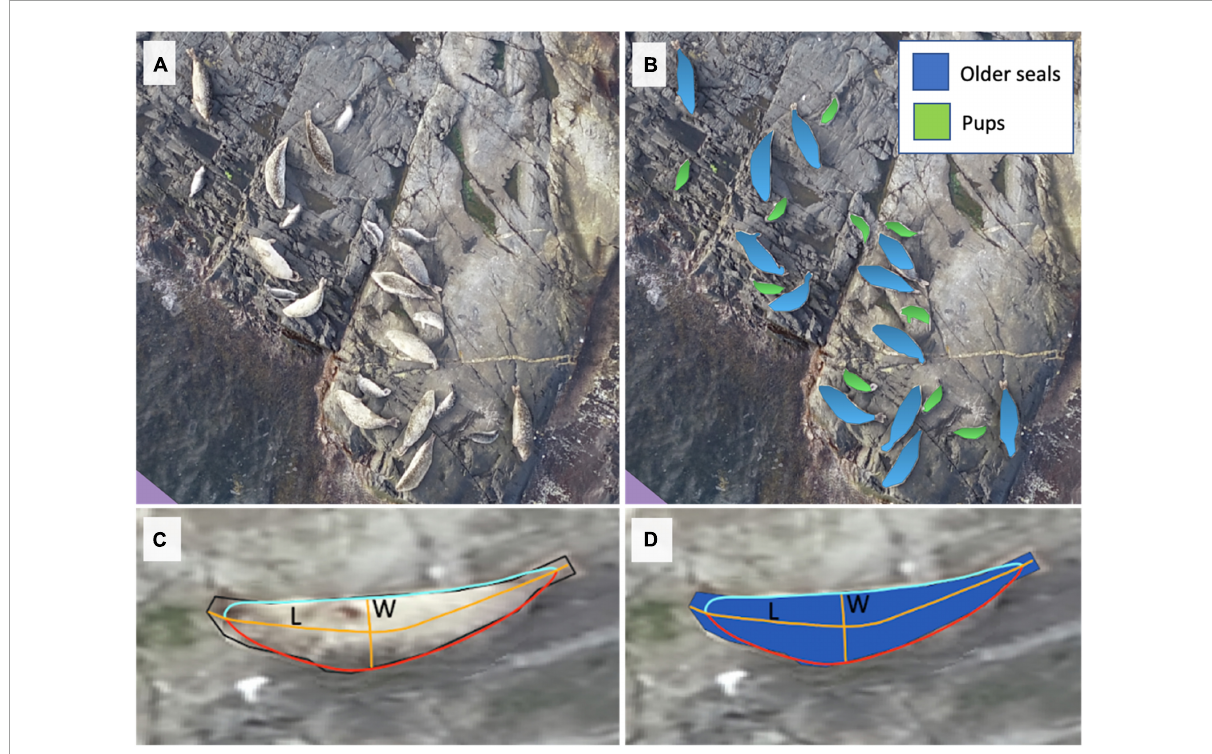
FIGURE3 Harbour seal identification using machine learning detectors at the locality “Svarta Kalvhättan,” Sweden, on the 18th of June 2021. (A) A drone orthomosaic map is composed of many overlapping photos. (B) Blue and green polygons indicate pups and older seals identified by machine learning, (C,D) automatic measurement of body lengths (L) and widths (W) describe seal shape. Polygons were smoothed and split into two line segments (red and light blue lines). Coordinate points midway between these segments were used to construct a line representing the position of the spine. To account for the effect of smoothing, the distance between the smooth and unsmoothed polygon was added to the length of this line to calculate seal length (long orange line). Widths were calculated based on the maximum distance between the curved line and the smoothed polygon (short orange line).